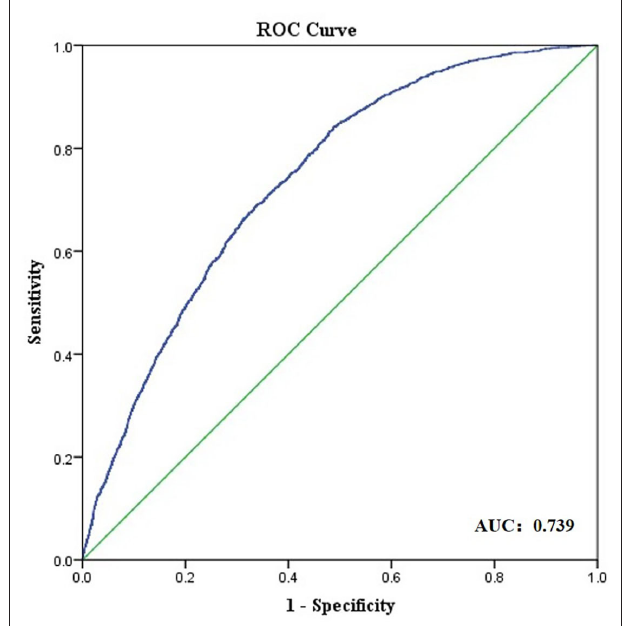
FIGURE 4 | Receiver operating characteristic (ROC) curve obtained for anterior segment parameters as predictors of ocular residual astigmatism (ORA) larger than 1.0